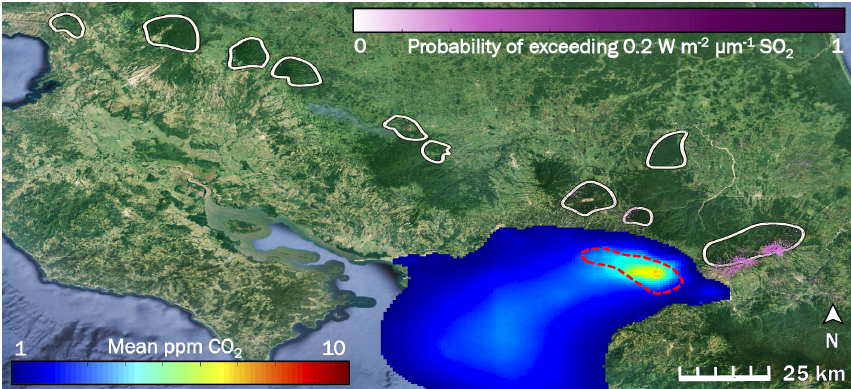
Figure 2. The influence of two potentially confounding gases on our study area (right-hand white shape) in Costa Rica is low to non-existent: anthropogenic CO 2 from San José (blue to red color scale), and volcanic SO 2 (purple color scale). White shapes are drawn around locations of the forested active volcanic edifices in Costa Rica. The red dashed line indicates the rough border of the San José urban area. Prevailing winds throughout the year consistently blow all anthropogenic CO 2 away from our study area and from all other white shapes.